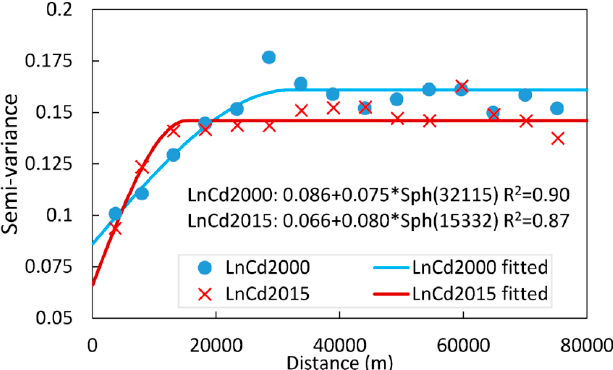
Figure 3. Experimental and fitted variograms of soil Cd (Cadmium) concentrations in the two sampling dates.